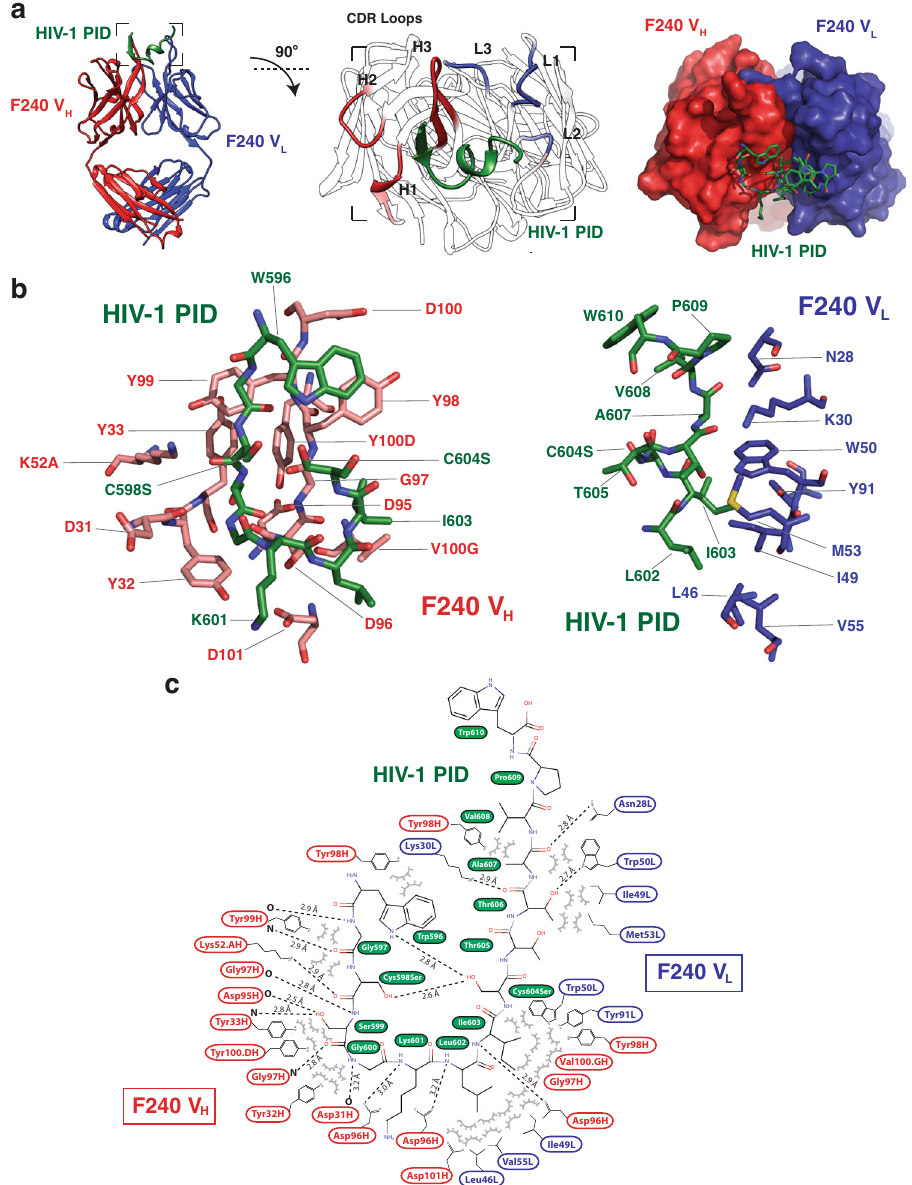
Fig. 3 Overall structure of Fab F240 complexed to HIV-1 gp41 PID. a The crystal structure of the Fab F240-PID complex shows the PID region in a β -strand-loop-helix conformation coordinated primarily by CDR loops L1, L2, H1, and H3. b Stick representation of the antigen-binding site in which the HIV-1 PID peptide is colored in the dark green, heavy chain in red, and light chain in dark blue. c Stick representation and interaction map of Fab F240 and the PID peptide. HIV-1 PID residue S598 (labeled Cys598Ser) and S604 (labeled Cys604Ser) recapitulate a 2.6-Å intramolecular disul fi de bond. Interactions were determined by PISA analysis 80 and manual inspection. Hydrogen bonds are shown by dashed